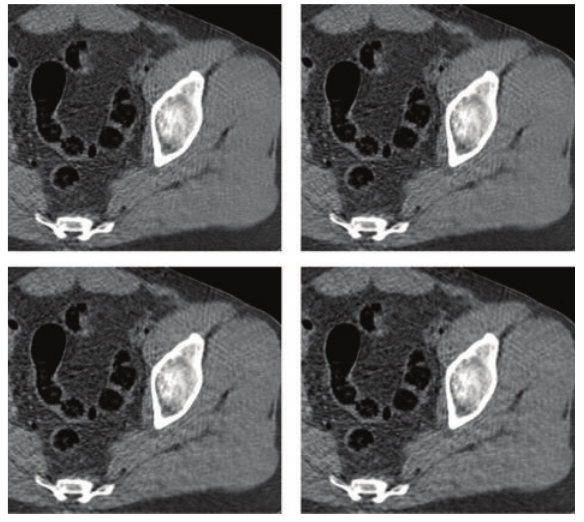
Figure 20: Left to right: reconstruction with learned shrinkage trained using varying regularization weight, = [0.001, 0.0032, 0.0316, 0.1] . 𝛾 𝐼